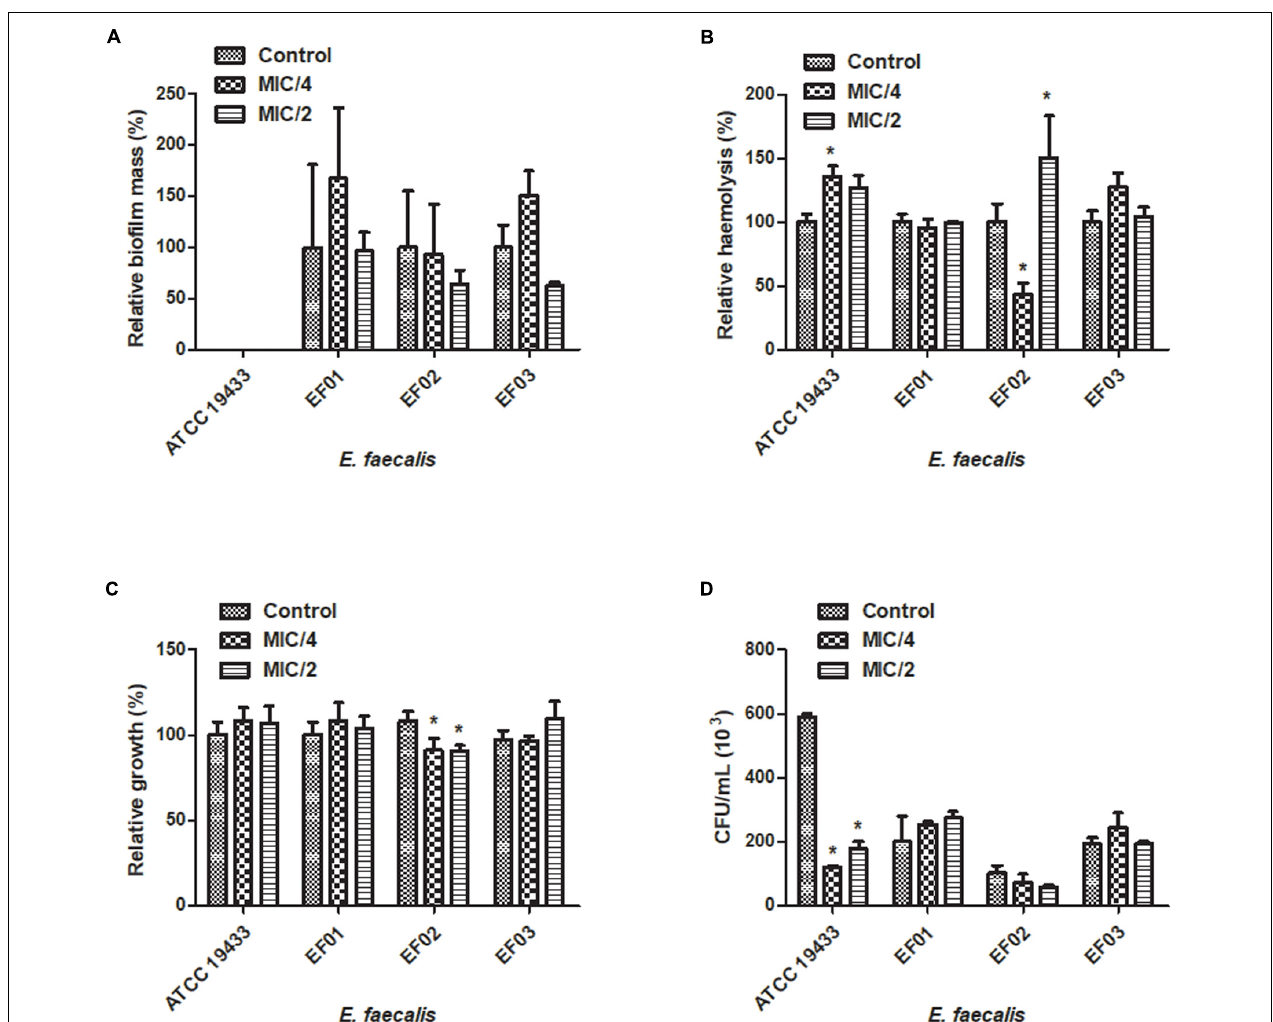
FIGURE 2 | Effect of cinnamaldehyde (MIC/2 and MIC/4) on virulence factors of Enterococcus faecalis strains. (A) Biofilm mass production; (B) Hemolytic activity; (C) Serum resistance; (D) Adhesion to latex (catheter). ∗ p < 0.05, compared with vehicle-treated controls. Experiments were performed three times in duplicate. Each bar represents mean +